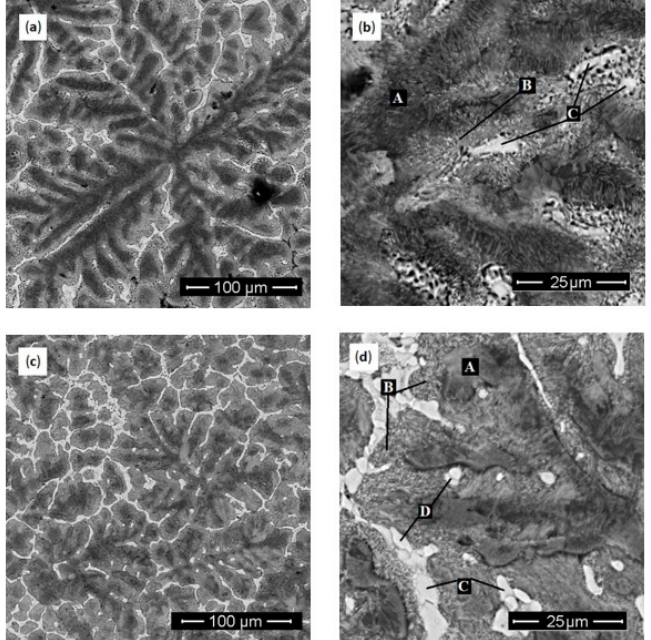
Figure 2. SEM micrographies of dendritic microstructure of the as-cast alloys: (a) and (b) ZA27 alloy; (c) and (d) ZA27-2%Cu-0.015%Mg alloy. Markers are explained in the main text.